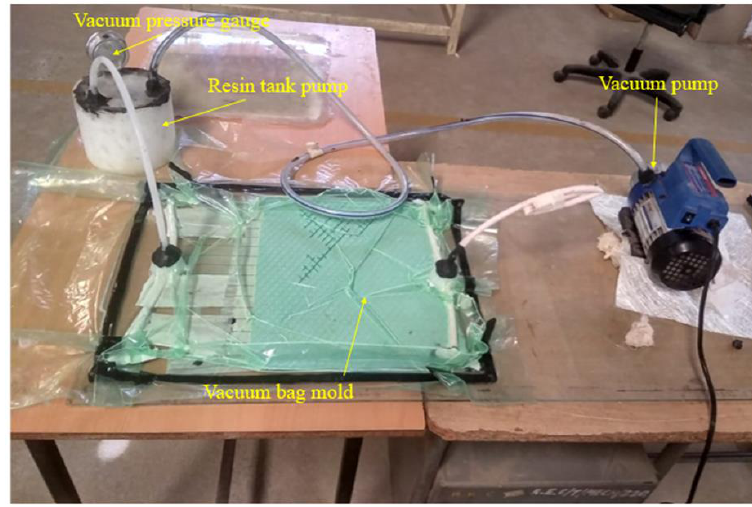
Figure 3. Composite materials are fabricated by vacuum bagging